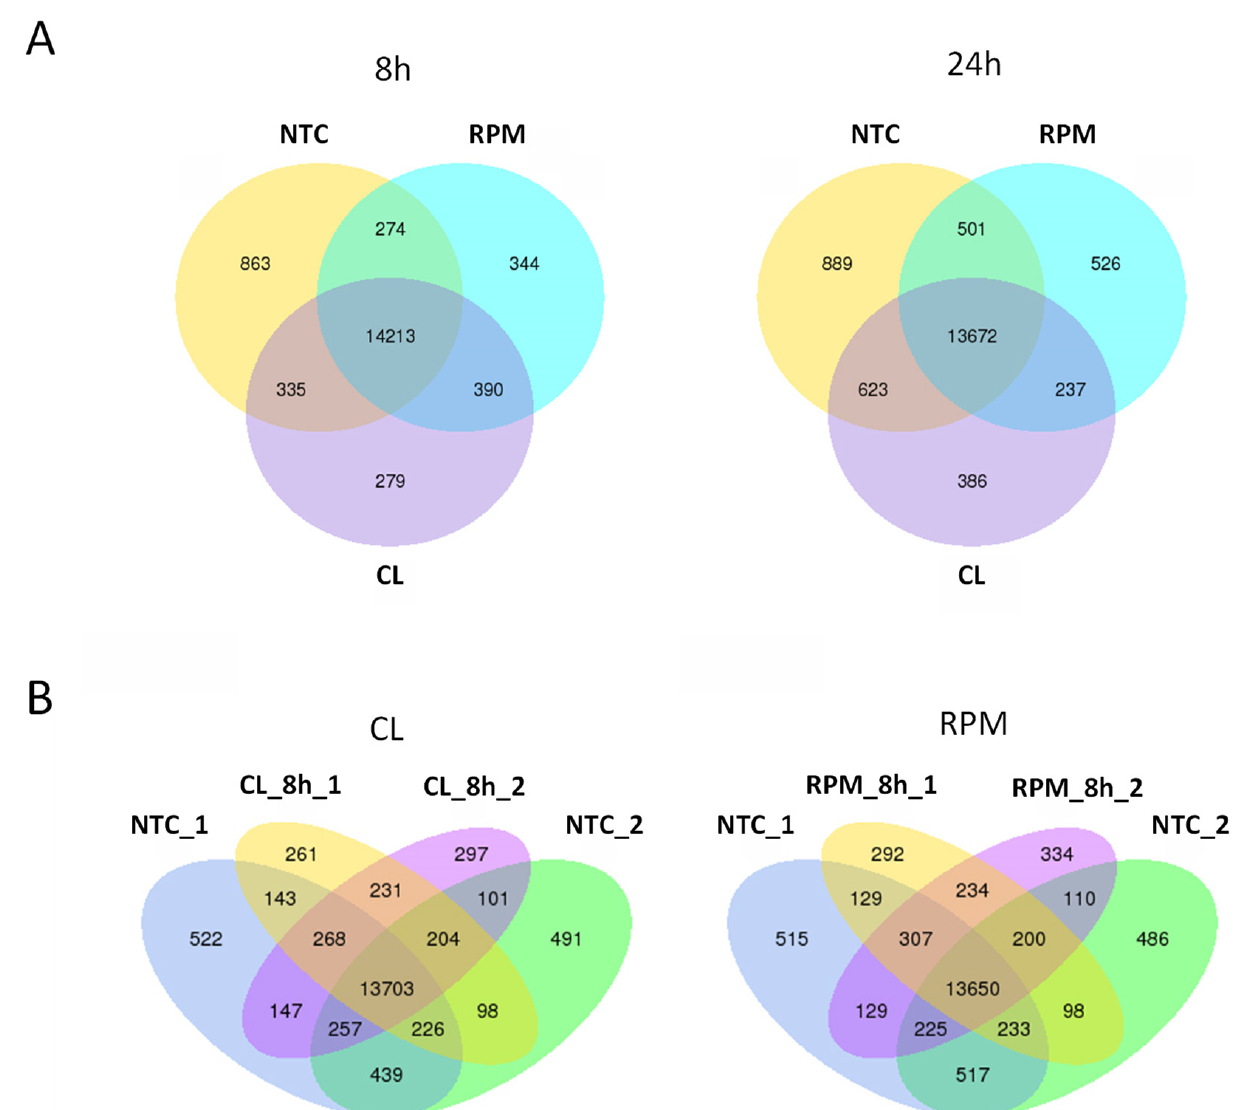
Figure 3. Venn diagrams indicating numbers of significantly expressed and co-expressed genes in mouse T cells in simulated microgravity experiment. ( A ) Gene expression in simulated micro- gravity experiment at 8 h and 24 h . Numbers of expressed and co-expressed genes shown at 8 h and 24 h of treatment by simulated microgravity in clinostat (CL) and random positioning machine (RPM) versus non-treated control (NTC). ( B ) Gene expression in biological duplicates at 8 h of simulated microgravity . Numbers of expressed and co-expressed genes indicated in biological du- plicates at 8 h in clinostat (CL) experiment (CL_8h_1, CL_8h_2) and random positioning machine (RPM) experiment (RPM_8h_1, RPM_8h_2) versus biological duplicates of non-treated control (NTC_1, NTC_2).